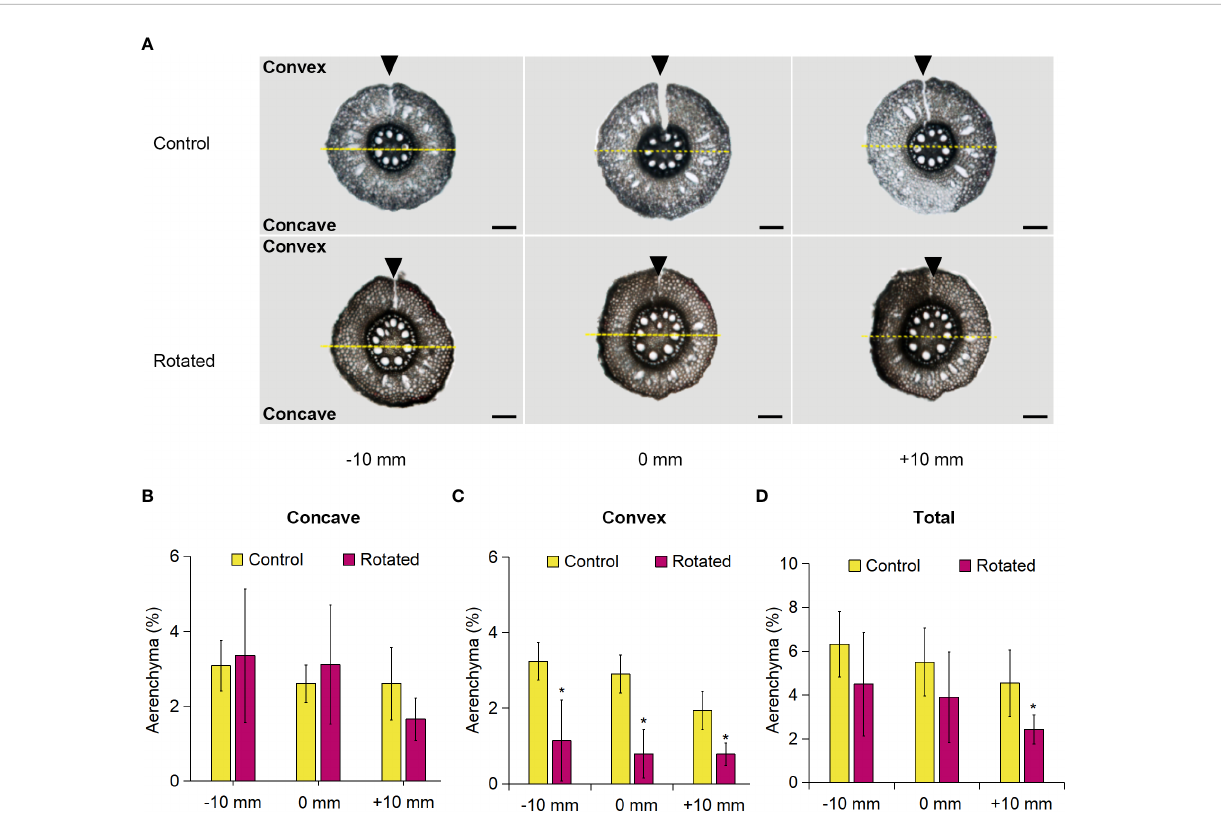
FIGURE 4 Aerenchyma formation on the concave and convex sides of the gravity-stimulated nodal roots of Z. nicaraguensis . (A) Cross-sections of the control and rotated nodal roots in the bent region (0 mm ± 2 mm) and at 10 mm (± 2 mm) from the bending position (at 0 mm). The parts cut by a razor blade are indicated with arrowheads. Scale bar = 1 mm. The percentage of aerenchyma formed at − 10, 0, and +10 mm on the concave side (B) and convex side (C) and the total percentage of aerenchyma formed in the nodal roots (D) . Signi fi cant differences between the control and rotated nodal roots at p < 0.05 (two-sample t- test) are denoted with asterisks. Values are mean ± SD ( n =